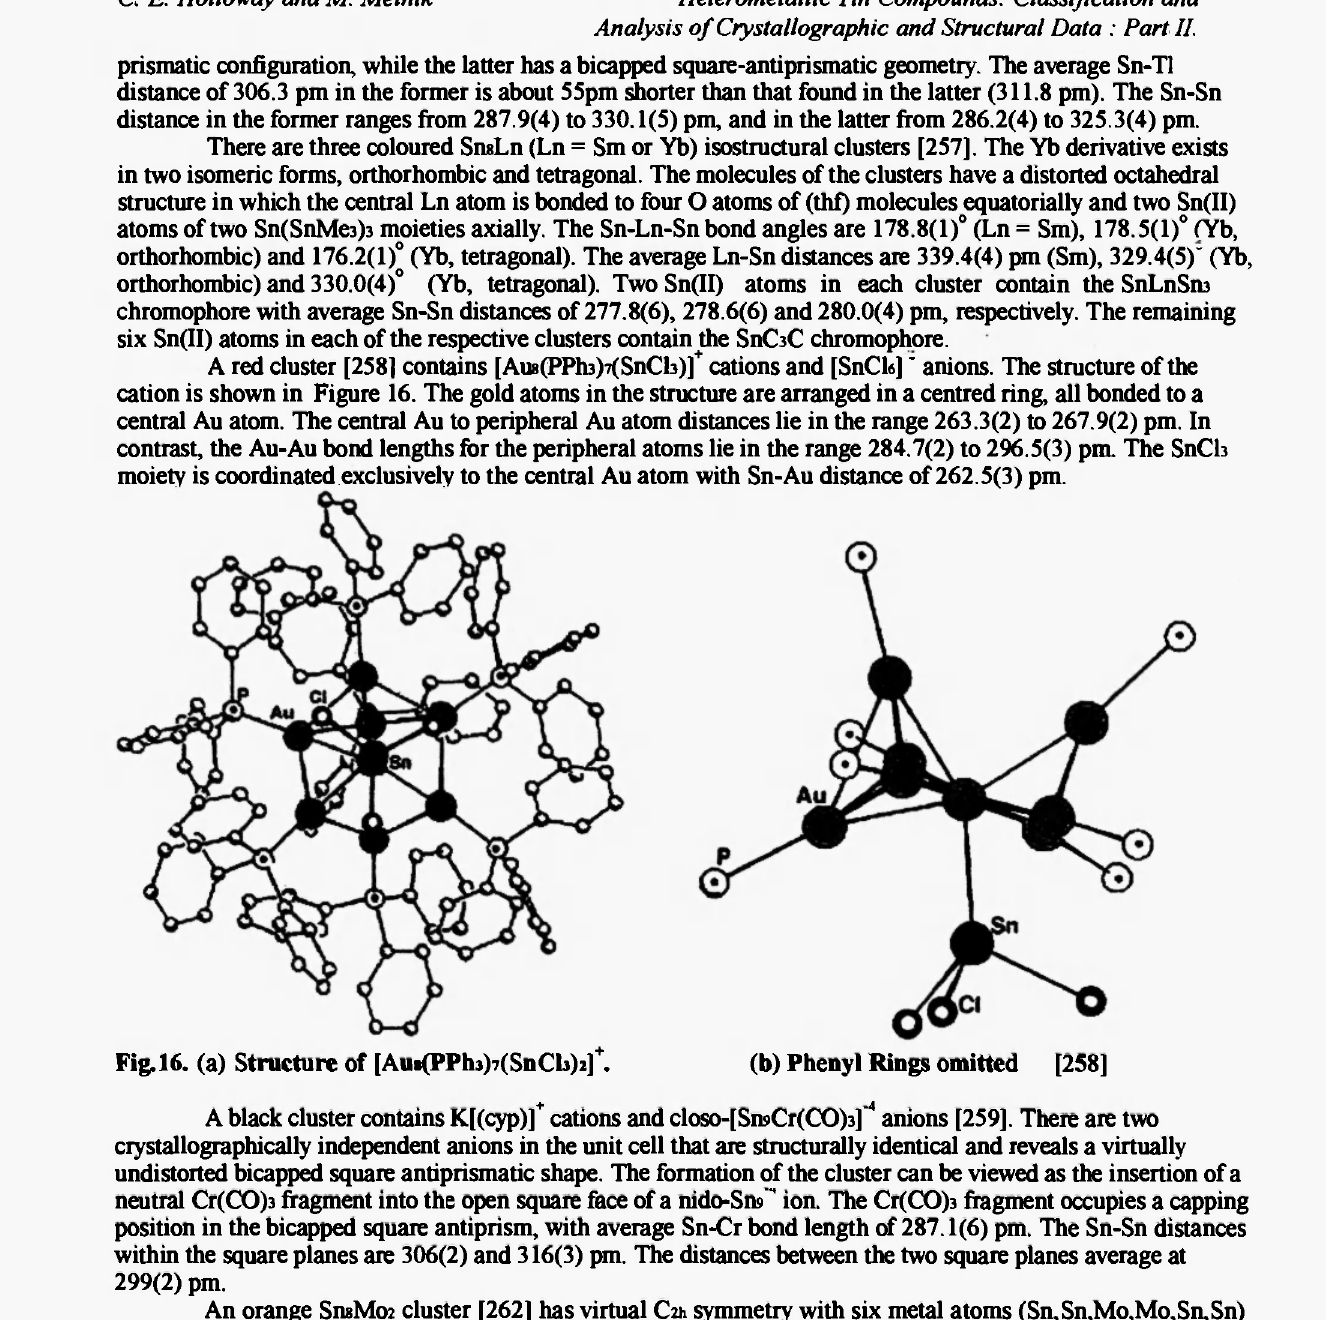
)7(SnCb) ] + . (b) Phenyl Rings omitted J 1